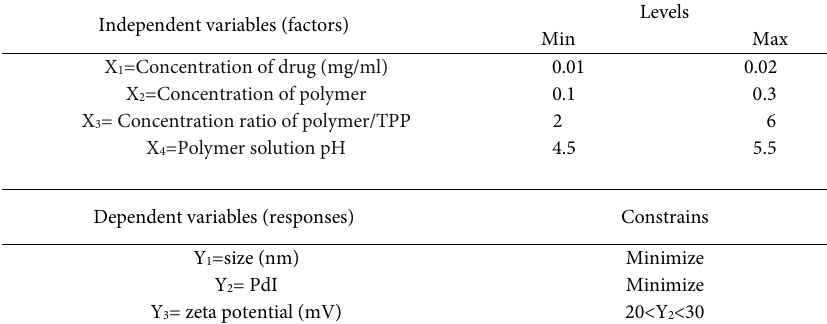
Table 1. Variables and levels used in RSM Table1. Variables and levels used in Independent variables (factors)